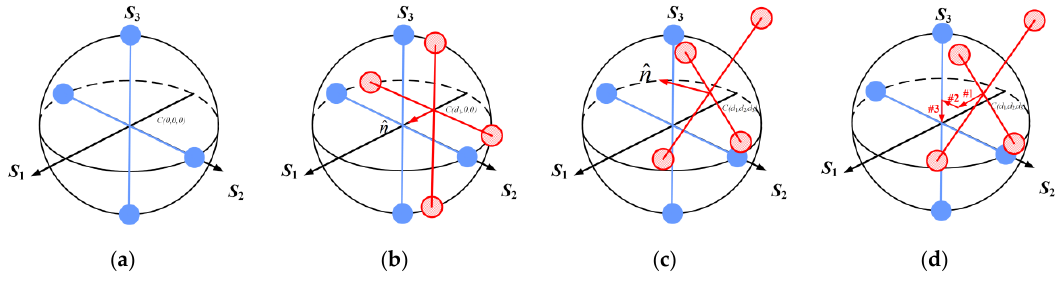
Figure 4. PDL compensation in Stokes space for a polarization-division multiplexing polarization- division multiplexing (PDM) quadrature phase-shift keying (QPSK) (PDM)-QPSK signal: ( a ) Original position; ( b ) signals suffer from PDL; ( c ) signals suffer from PDL and rotation of state of polarization (RSOP); ( d ) power inequality